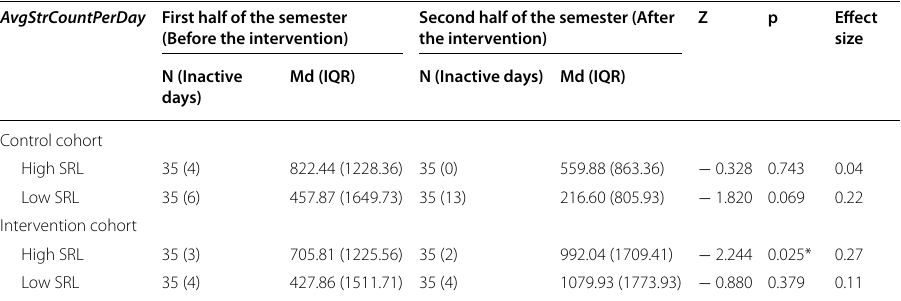
Table 5 Wilcoxon signed rank test on AvgStrCountPerDay of SRL clusters compared before and after the intervention